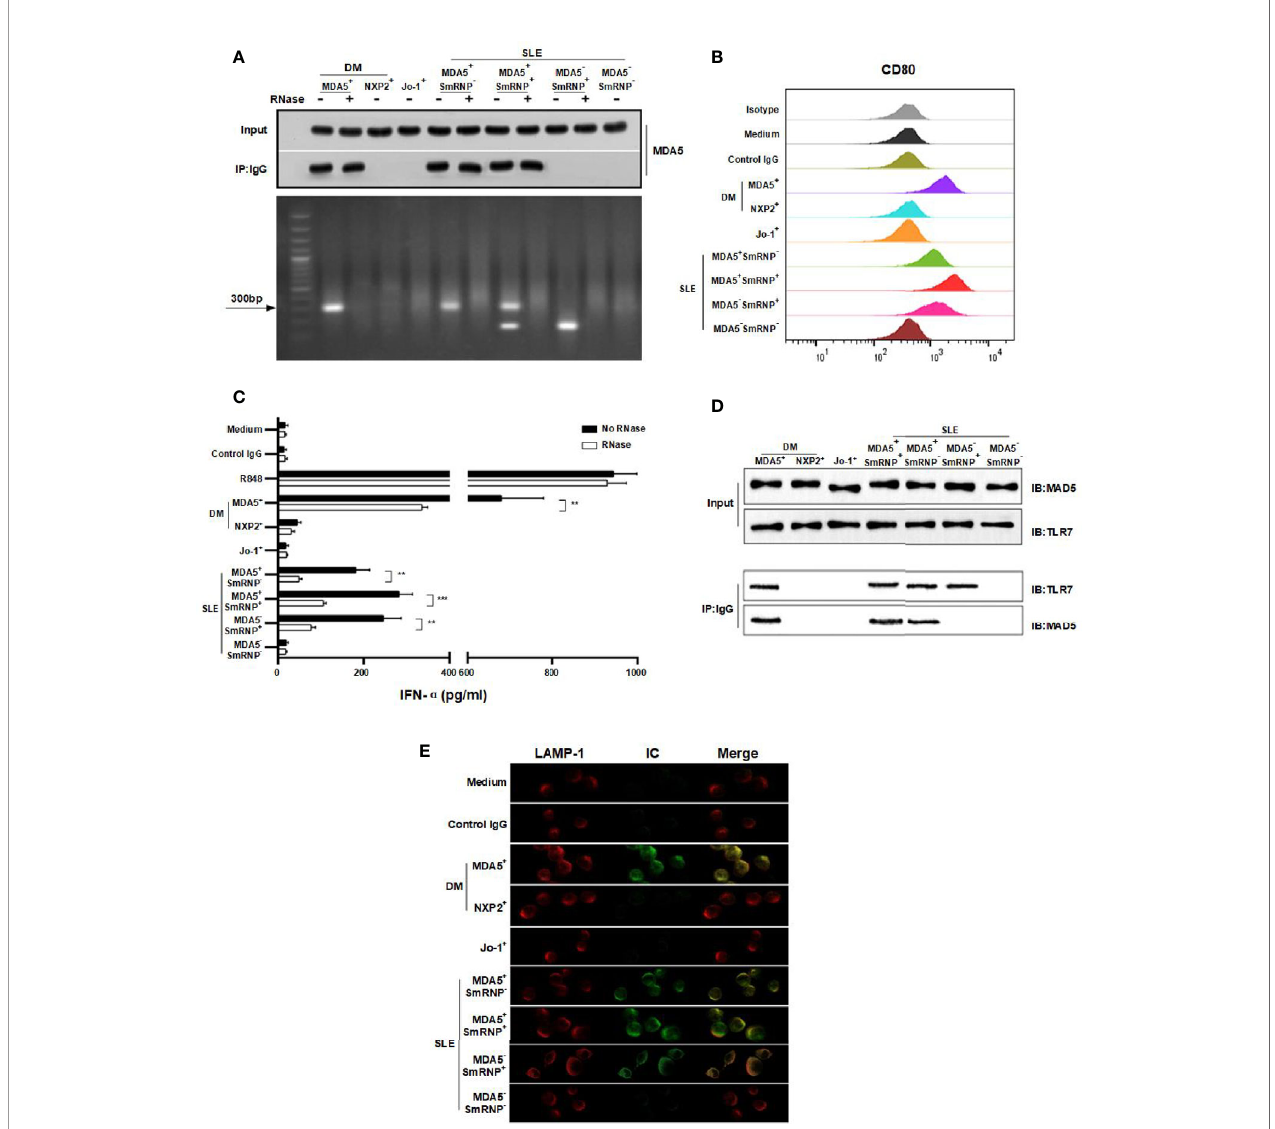
FIGURE 2 | Anti-melanoma differentiation-associated gene 5 (MDA5) immune complexes (ICs) induce interferon alpha (IFN- a ) production in plasmacytoid dendritic cells (pDCs). (A) MDA5 ICs contain RNA (~300 bp). (B) Puri fi ed pDCs were cultured with MDA5 ICs overnight and stained for CD80 expression. (C) RNA is required for MDA5 ICs to activate pDCs to release IFN- a . (D) Co-immunoprecipitation (co-IP) veri fi ed protein interaction between Toll-like receptor 7 (TLR7) and MDA5 ICs. (E) Confocal images show lysosome-associated membrane protein 1 (LAMP-1) ( red ), ICs ( green ), and the merged image ( yellow ). Results represent at least three biological independent repeats for all experiments (A – E)